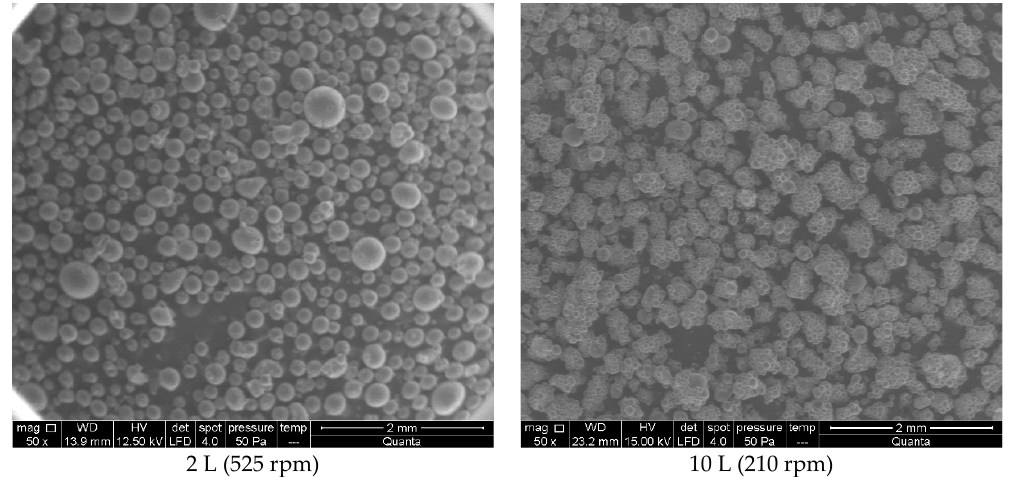
Figure 4. SEM micrographs of 2 and 10 L reactions.